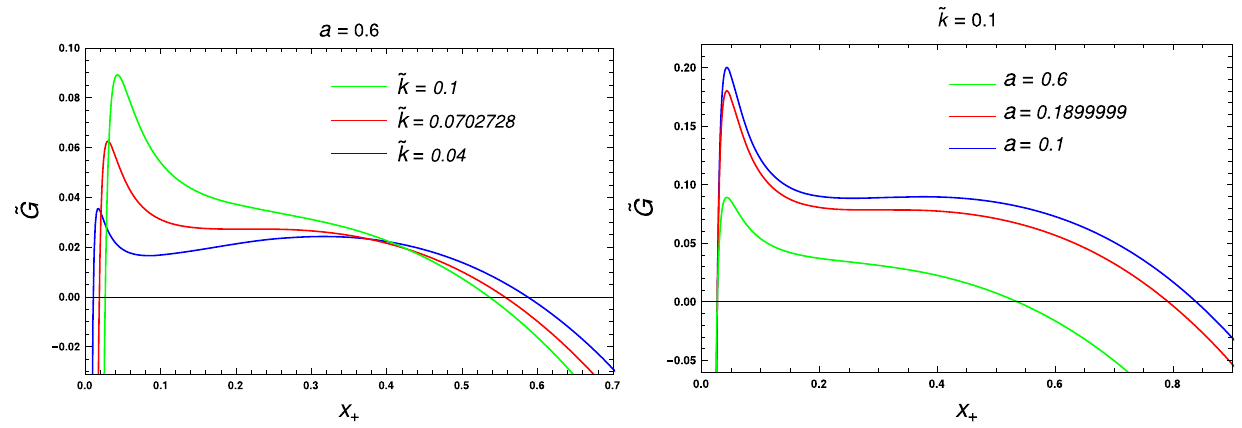
Fig. 5 The plot of Gibbs free energy ˜ G vs horizon x + for nonsingular-Ads black hole surrounded by clouds of strings for different values of clouds of strings parameter a